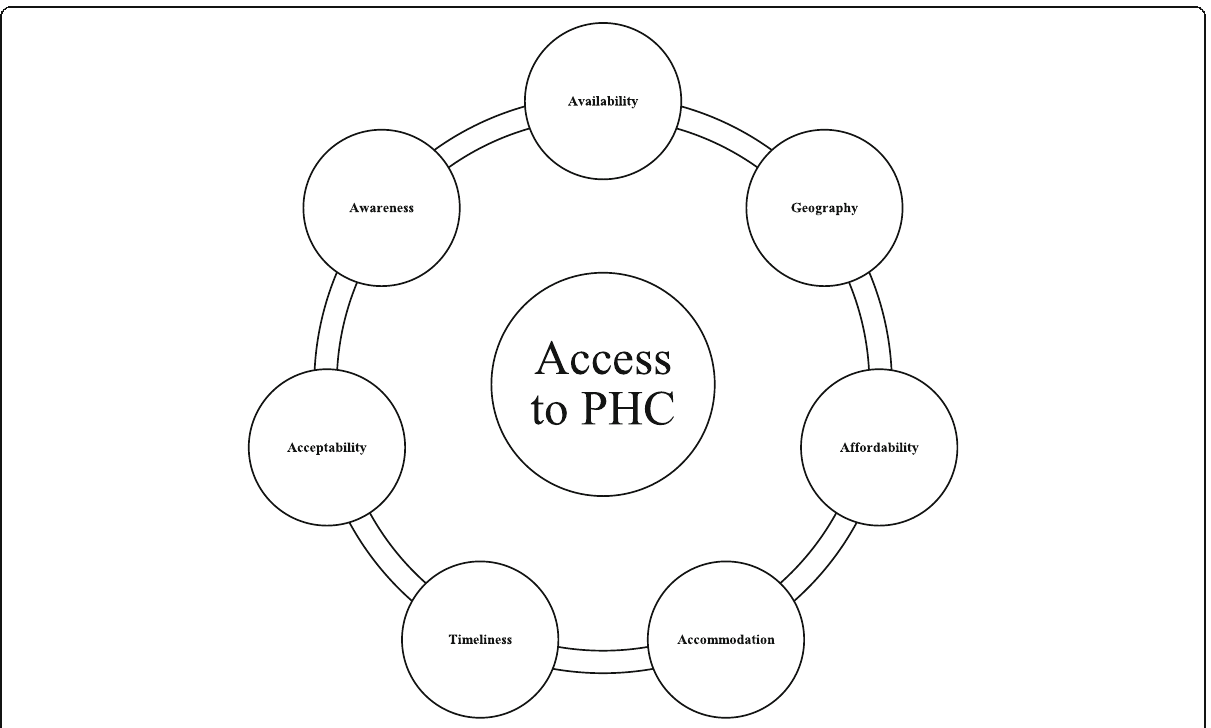
Fig. 2 Conceptual Framework Showing Interconnections among the Access